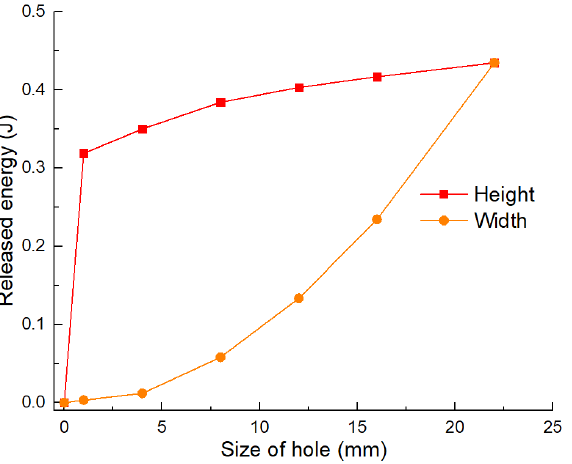
Figure 12. Strain energy release caused by different height and width of excavation holes.